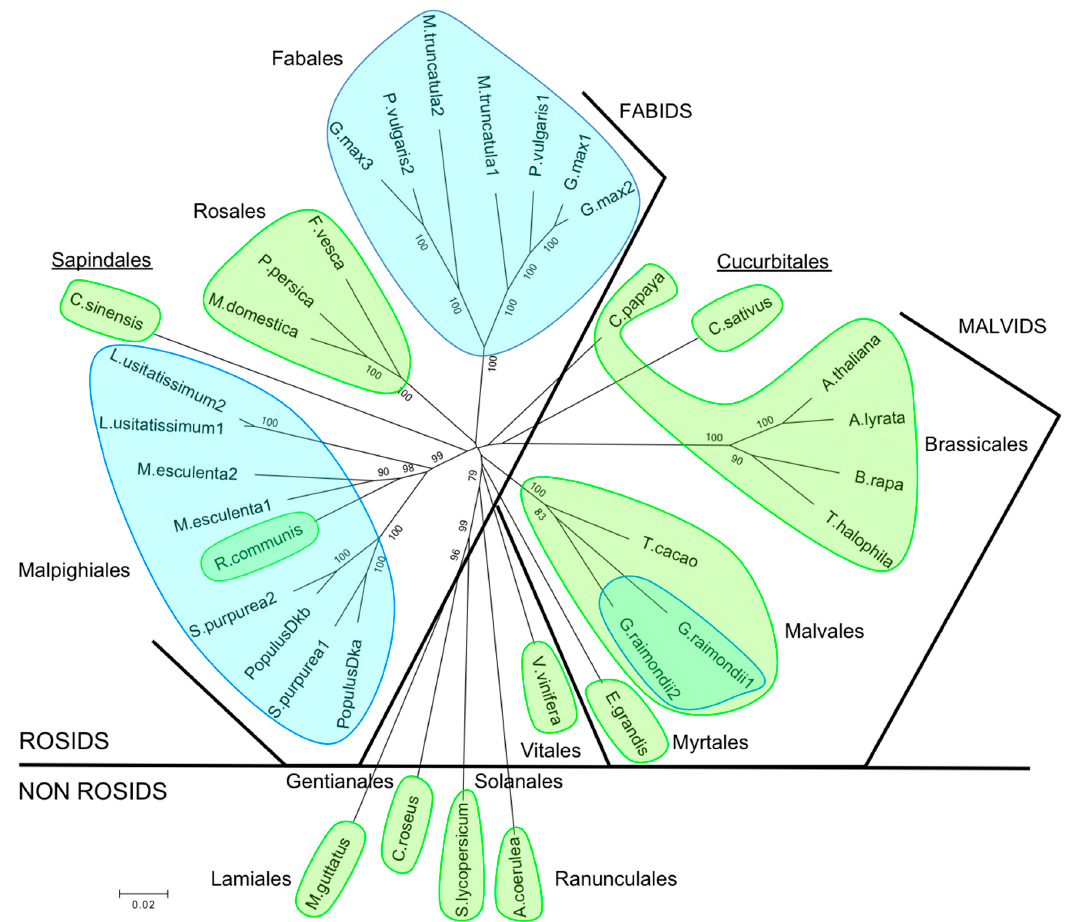
Figure 1. Unrooted relationship tree of Histidine-aspartate Kinases 1 (HK1s) from Populus and other plants. Amino acid sequences of HK1a ( Populus Dka, accession No. AJ937747) and HK1b ( Populus Dkb, accession No. LT622839) were aligned with HK1 homologous proteins of Arabidopsis ( A. thaliana , AT2G17820 and A. lyrata , 480680), saltwater cress ( T. halophila , XM_006409179), turnip ( B. rapa , Brara.G00235), cucumber ( C. sativus , Cucsa.322710), papaya ( C. papaya , evm.TU.supercontig_6.277), cocoa ( T. cacao , Thecc1EG000177), cotton ( G. raimondii , Gorai.007G049200 and Gorai.003G008400), peach ( P. persica , Prupe.7G170700), apple ( M. domestica , MDP0000276711), strawberry ( F. vesca , gene14583-v1.0-hybrid), sweet orange ( C. sinensis , orange1.1g001044m.g), rose gum ( E. grandis , Eucgr.I02335), grape vine ( V. vinifera , GSVIVG01018749001), Colorado blue columbine ( A. caerulea , Aqcoe6G223000), tomato ( S. lycopersicum , Solyc02g083680), Madagascar periwinkle ( C. roseus , AF534893), yellow monkeyflower ( M. guttatus , Migut.L00691), purple willow ( S. purpurea , SapurV1A.0698s0020 and SapurV1A.0130s0330), castorbean ( R. communis , 29656.t000014), cassava ( M. esculenta , Manes.02G106100 and Manes.01G147600), flax ( L. usitatissimum , Lus10041891.g and Lus10028438.g), barrelclover ( M. truncatula , Medtr5g022470 and Medtr8g075340), common bean ( P. vulgaris , Phvul.002G107100 and Phvul.003G264600) and soybean ( G. max , Glyma01g36950, Glyma11g08310 and Glyma02g05220) by CLUSTALW and were represented as a phylogram constructed with the neighbour-joining method and 1000 bootstrapping replicates. The bootstrap values higher than 75% are indicated on the tree. The scale bar represents 0.02 amino acid substitution per site. Each classification order is circled and classification clades are separated by thick black lines. The two underlined orders belong to the opposite clade. Plant species with one HK1-like gene are highlighted in green and plant species with at least two HK1-like genes are highlighted in blue.